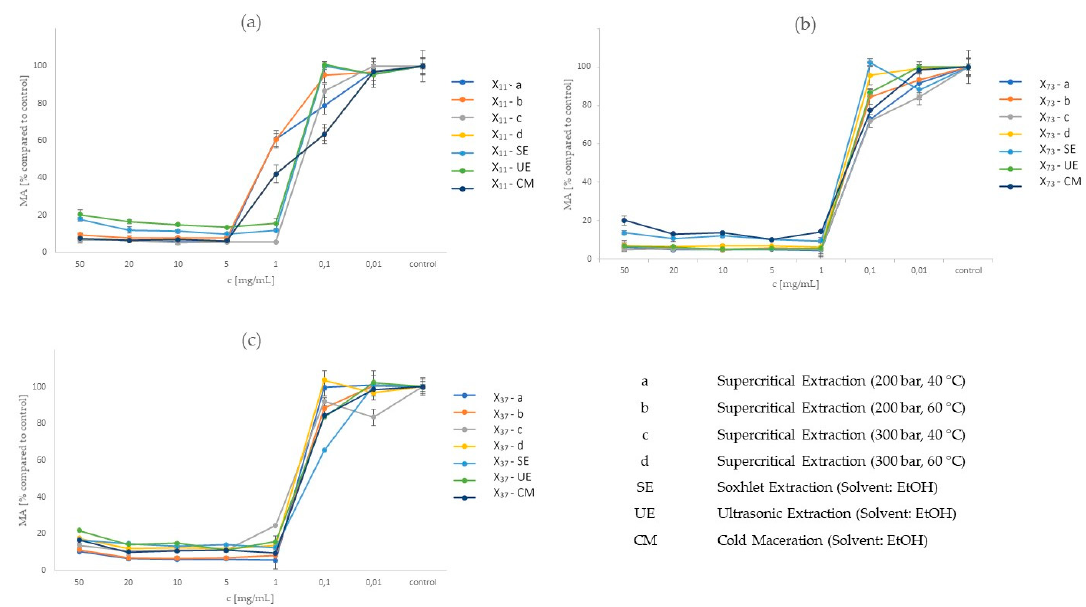
Figure 2. Metabolic activity at different concentrations of ginger and industrial hemp mixture using different extractions (SCF-a, SCF-b, SCF-c, SCF-d, SE, UE, CM). ( a ) x 11 extract prepared in a 1:1 ratio of ginger to hemp. ( b ) x 73 extract prepared in a 7:3 ratio of ginger to hemp. ( c ) x 37 extract prepared in a 3:7 ratio of ginger to hemp.